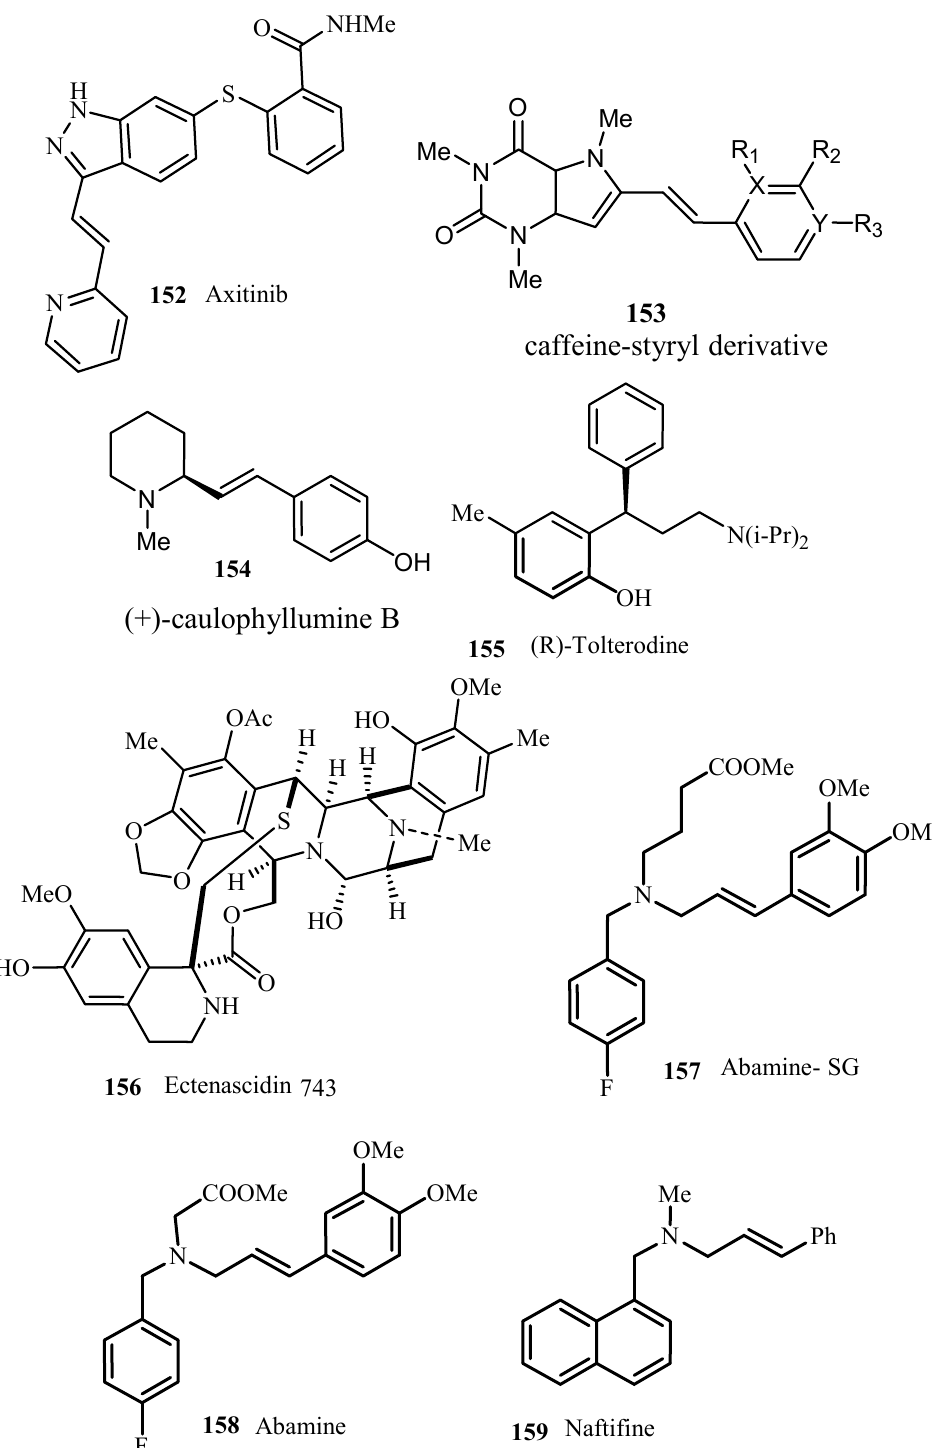
Figure 23. Drug components or drug candidates exploited for inter and intramolecular Heck coupling by Biajoli et al. [85].